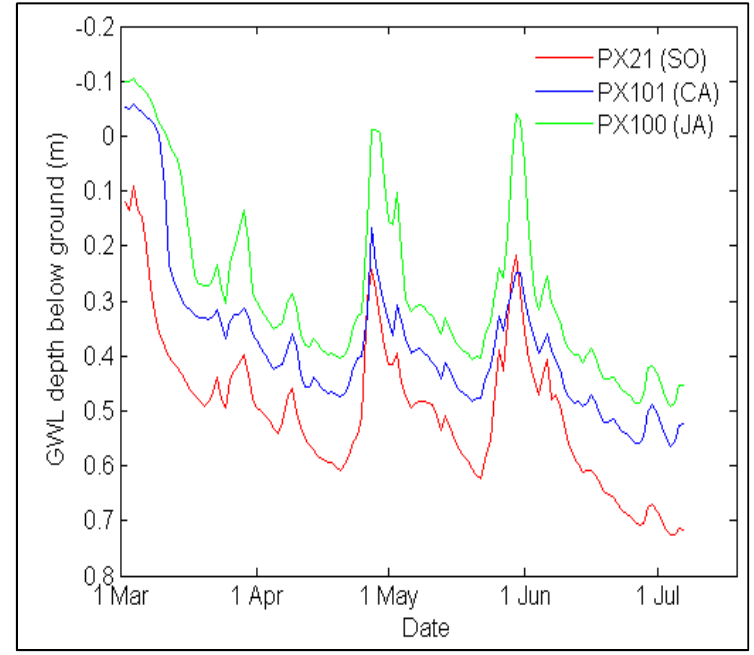
Figure 9. Groundwater levels (from 1 March to 5 July 2014) in boreholes in the SO, CA and JA dominant parts of Yarnton Mead.